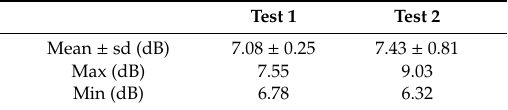
Table 7. SNR improvements for denoising algorithm trained on armband sequences (test 1) and sequences from MIT-BIH arrhythmia database (test 2).